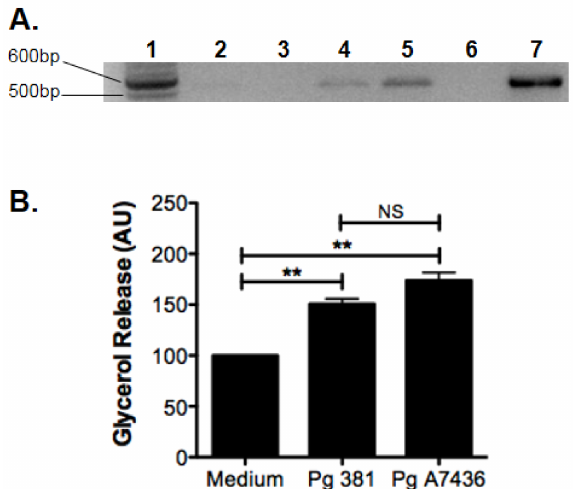
Figure 2. Porphyromonas gingivalis DNA is detected in adipose tissue excised from mice following oral challenge with live bacteria, and this organism can influence adipocyte function by enhancing glycerol release in vitro. ( A ) PCR-based detection of P. gingivalis 16S DNA (527 bp) in epididymal fat from unchallenged ( n = 2) C57BL-6 mice, or 24 h following oral challenge with P. ginigvalis strain 381 ( n =